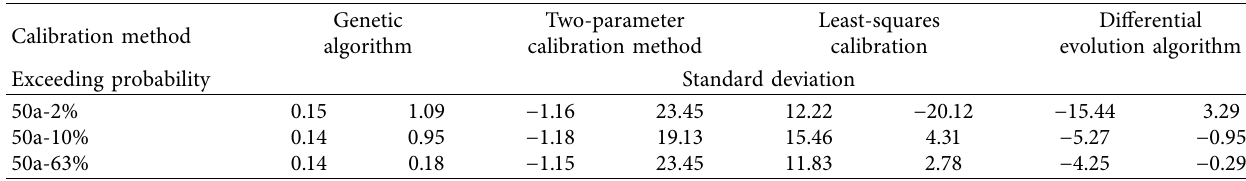
Table 11: Error analysis table of four calibration